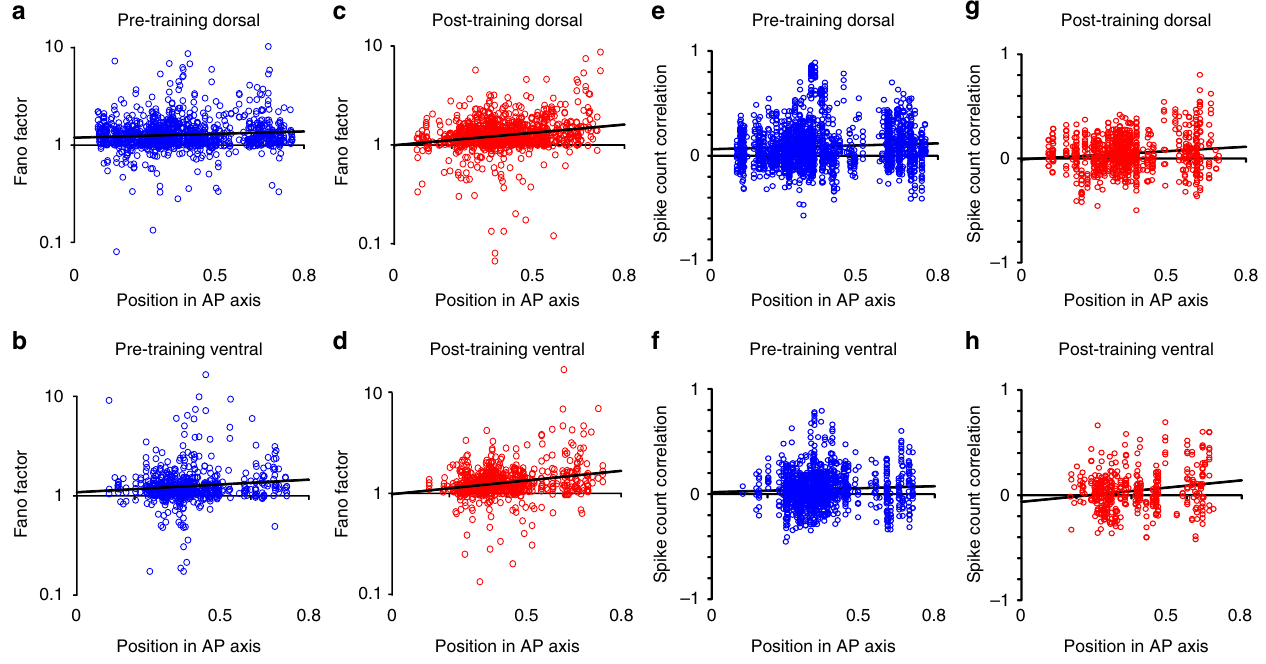
Fig. 6 Variability and correlation. a Fano factor values based on spike counts in the delay period are plotted along the anterior-posterior axis of the dorsal prefrontal cortex before training. Line represents linear regression. b Fano factor values in the ventral prefrontal cortex. c , d Fano factor values after training. Total sample size in panels ( a – d ): n = 3508 neurons. e Spike-count correlation values computed during the delay period are plotted along the anterior- posterior axis of the dorsal prefrontal cortex before training. f Spike-count correlation in the ventral prefrontal cortex prior to training. g , h Spike-count correlation values after training. Total sample size in panels ( e – h ), n = 4668 pairs of simultaneously recorded neurons from separate electrodes, spaced 0.5 – 1 mm